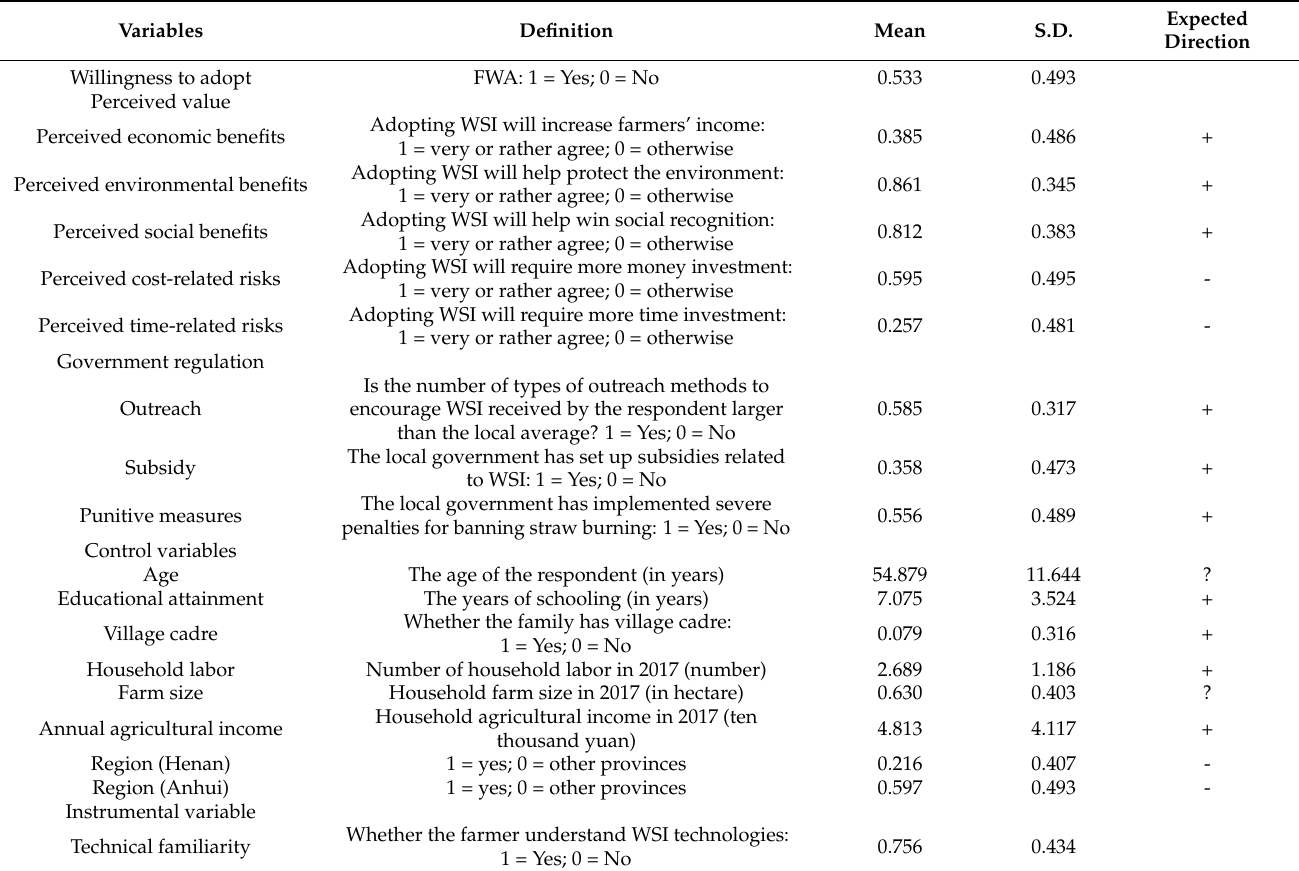
Table 1. Definitions and descriptive statistics of the